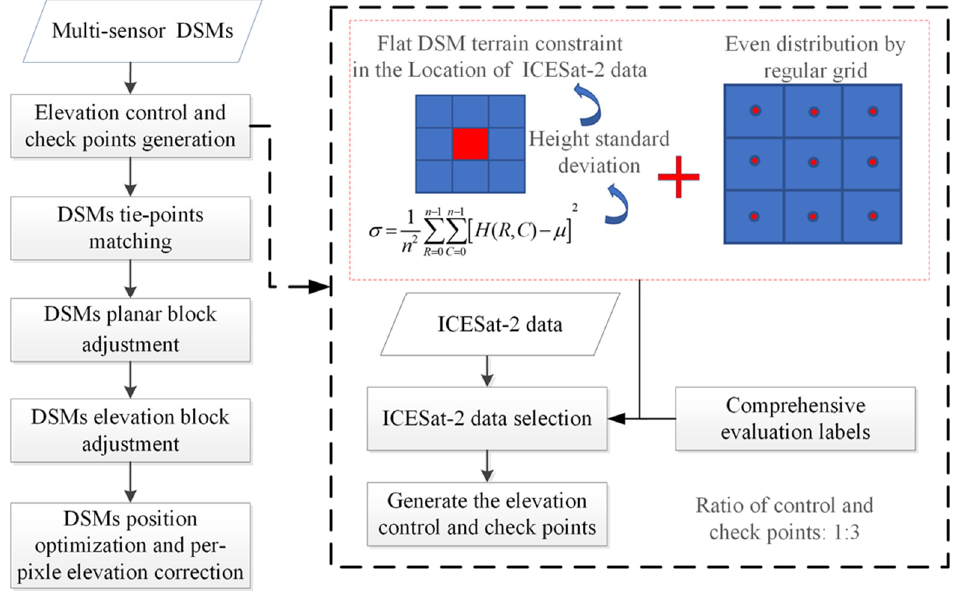
Figure 1. Flowchart of the proposed method.